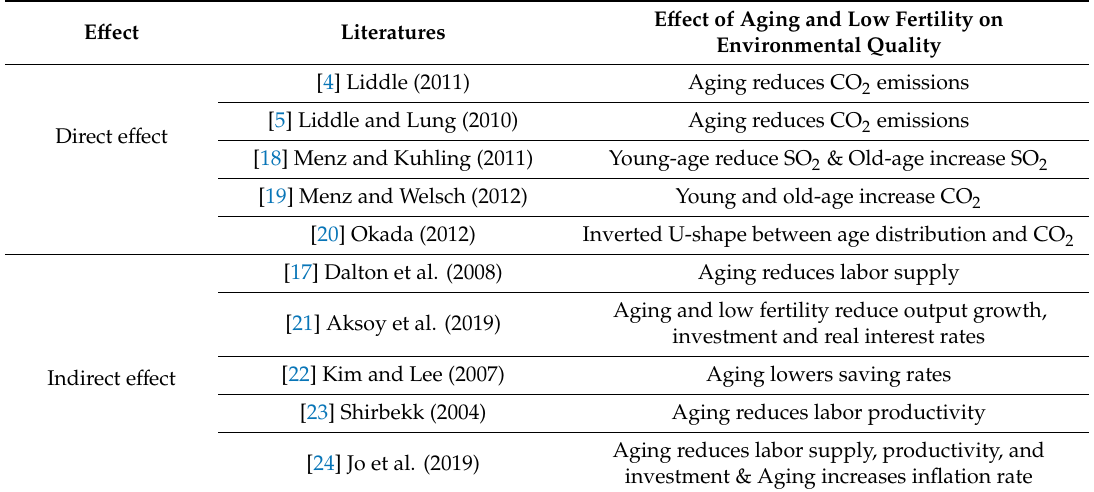
Table 1. Literature survey on the e ff ect of aging and low fertility on environmental quality.